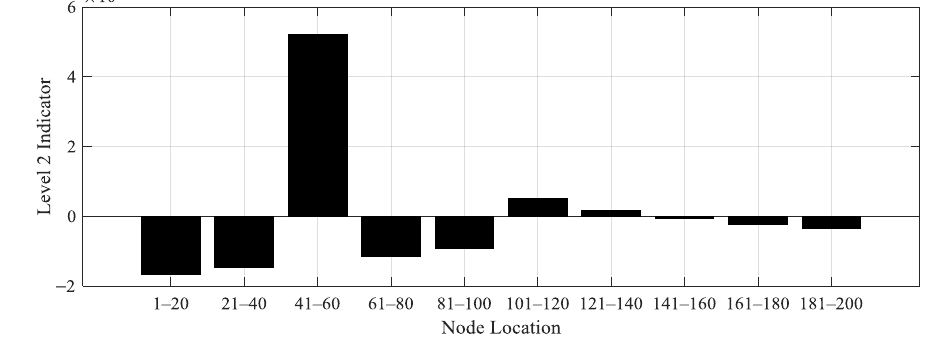
Figure 22. Level 2 damage indicator for Case 3.